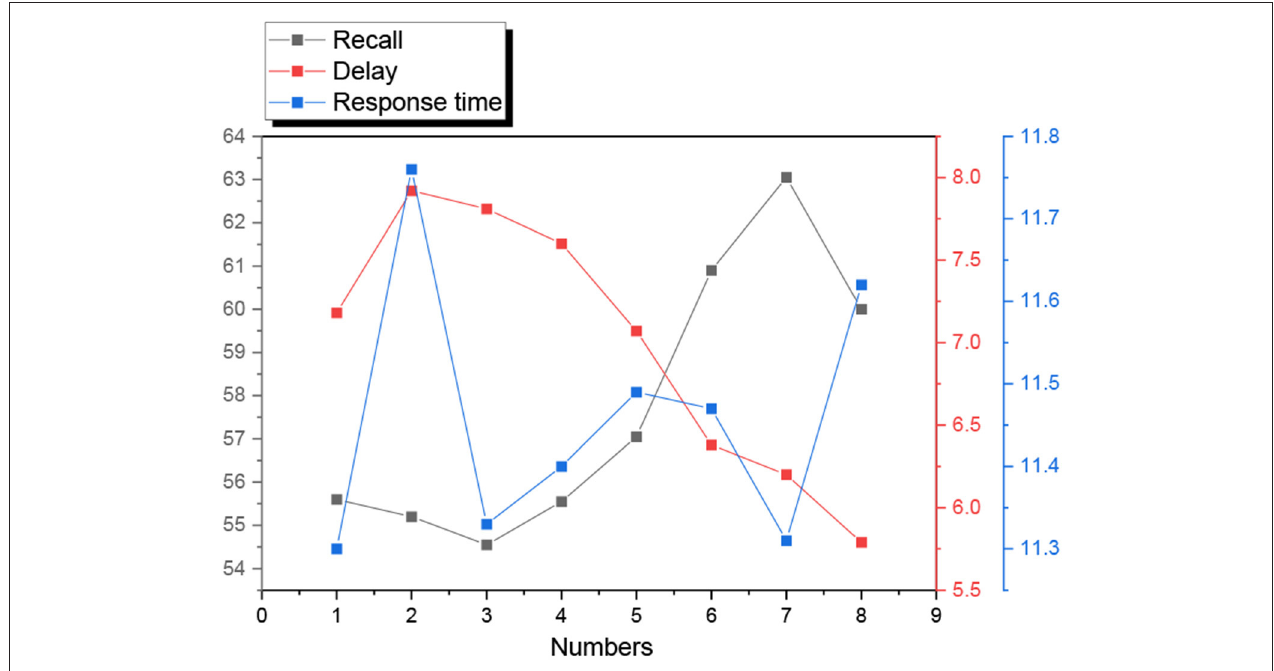
FIGURE 4 | Clustering results of brand switching intention.